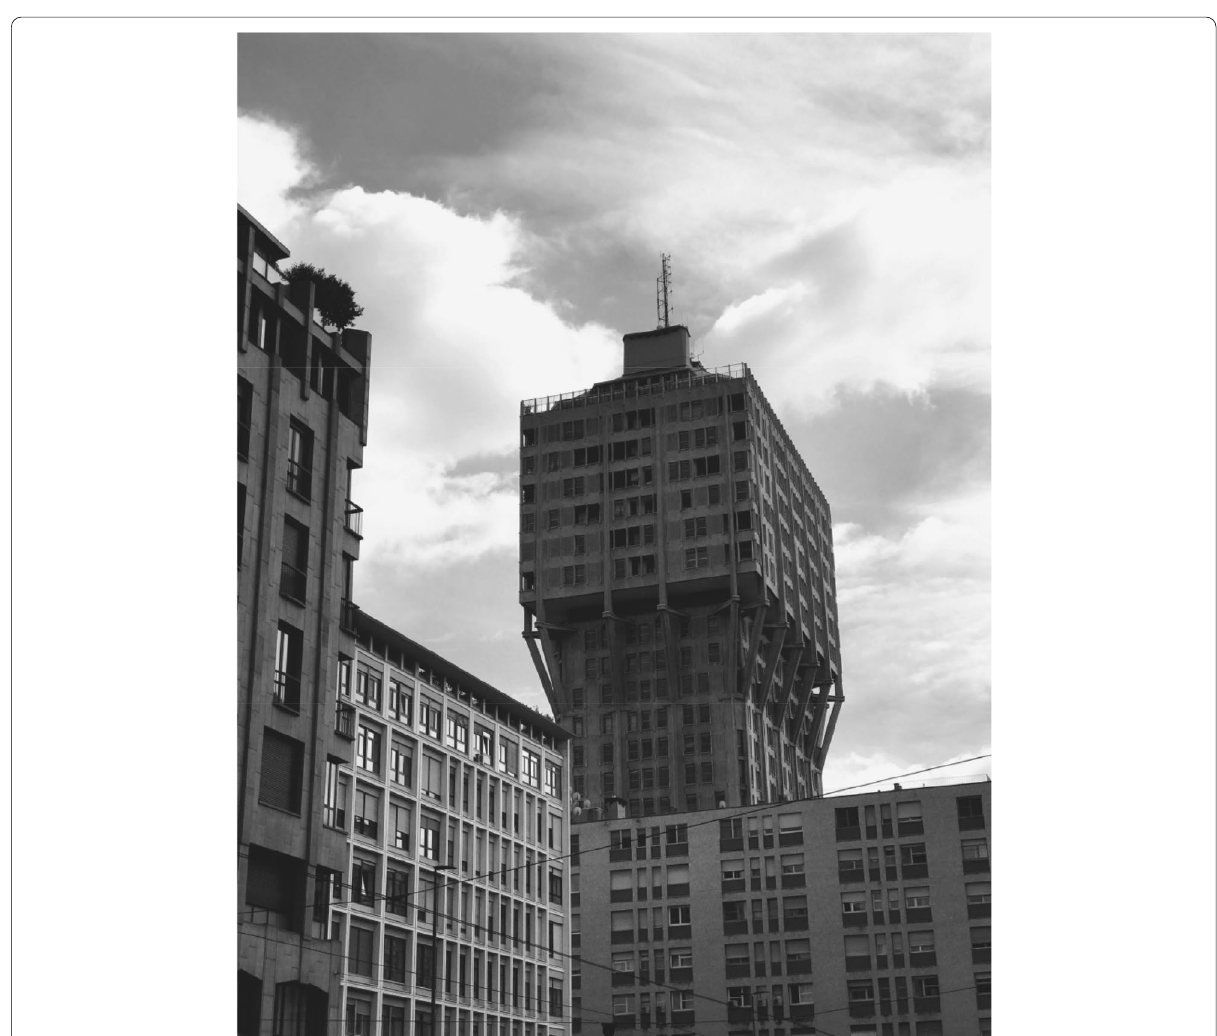
Fig. 10 Torre Velasca (1950–8) by Ludovico Belgiojoso, Enrico Peressutti and Ernesto Nathan Rogers (BBPR). Photograph taken by Marianna Charitonidou, 13 June